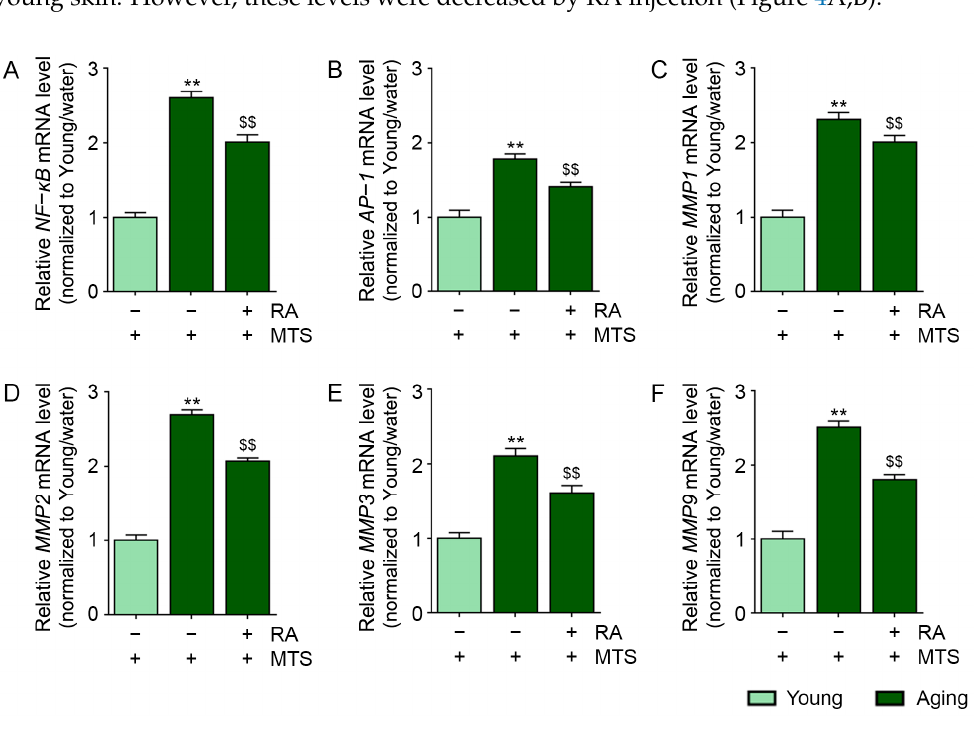
Figure 4. RA treatment decreased NF- κ B/AP-1 and MMP1/2/3/9 expression in aged mouse